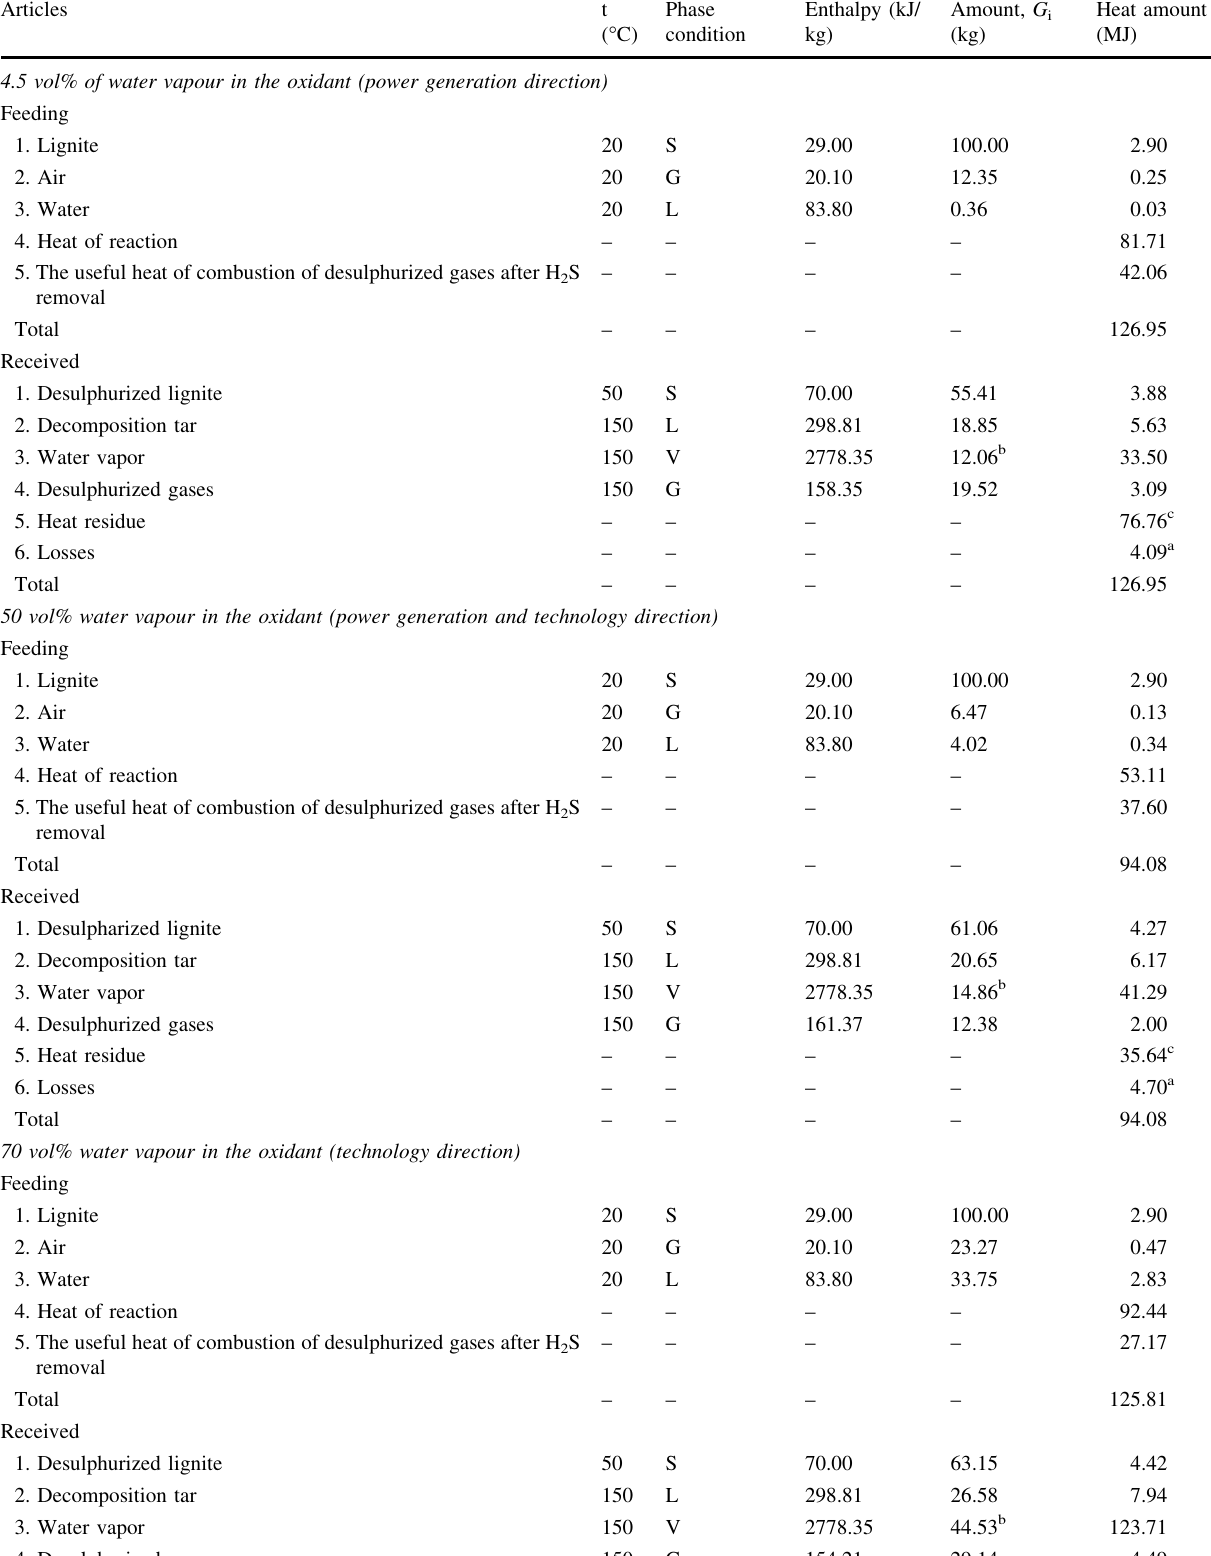
Table 6 Material and heat balances of the lignite oxidative desulphurization